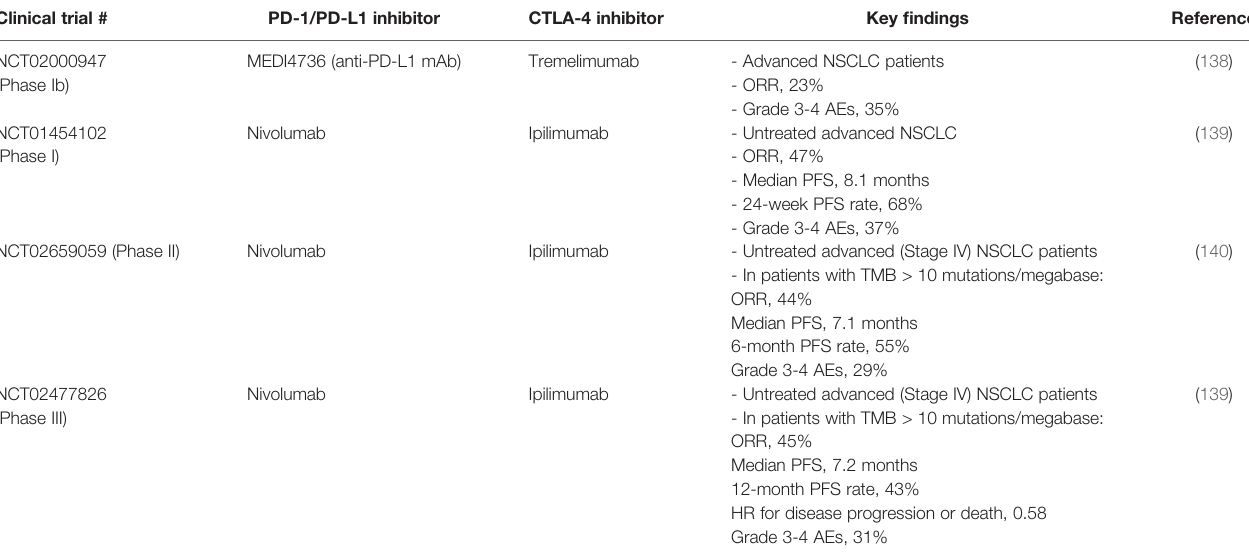
TABLE 4 | Representative clinical trials investigating the combination of PD-1/PD-L1 and CTLA-4 blockade immunotherapies in NSCLC. Clinical trial